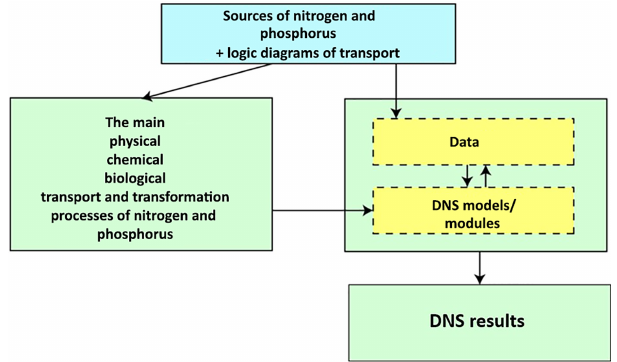
Figure 3. Macromodel DNS scheme (source: Ostojski, 2012). a unified tool combining existing and verified mathematical models and equations of hydrological transport process